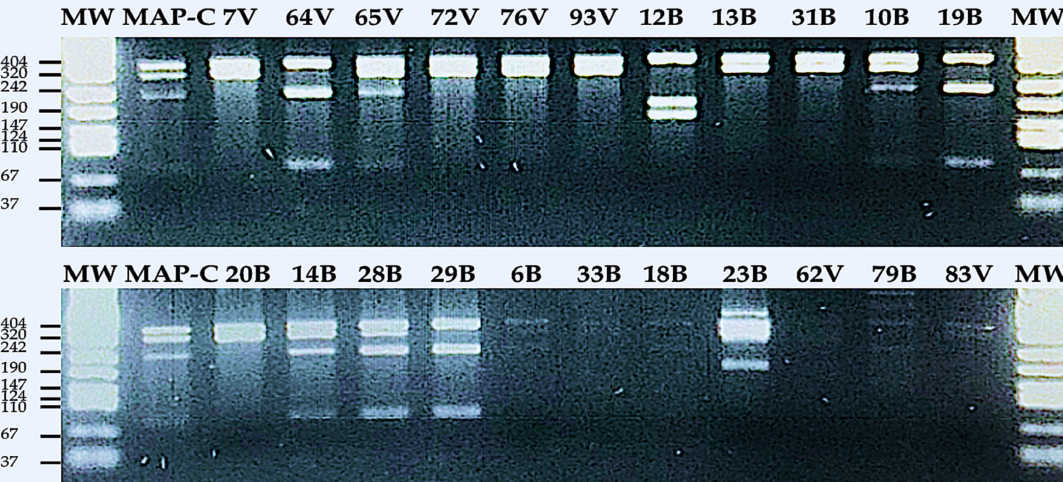
Figure 3. Restriction enzyme analysis (REA) on IS 1311 -positive PCR products obtained from sheep-milk samples. The first and last lanes are 100-bp marker (MW); second lane is MAP standard strain 1515 (MAP-C). The remaining lanes belong to IS 1311 -targeted amplicons from sheep-milk samples that underwent REA analysis. Samples “13B, 20B, 31B, and 33B” at the BTM level and “7V, 62V, 72V, 76V, 83V, and 93V” at the individual level (MIF) are S-type while samples “6B, 10B, 14B, 23B, 28B, and 79B” at the BTM level and “65V” at MIF level are C-type, bison type samples “18B, 19B, and 29B” at the BTM level and “64V” at MIF level were also observed. Sample 12B yielded an unusual pattern not seen before (B and V letters by the numbers are indicating BTM and individual milk sample respectively). Table 4. Distribution of 23 IS 1311 -positive samples in BTM and MIF categories, based on the type of MAP strain (S/C/bison) and corresponding RE fragments on gel-electrophoresis. Sample Strain Type